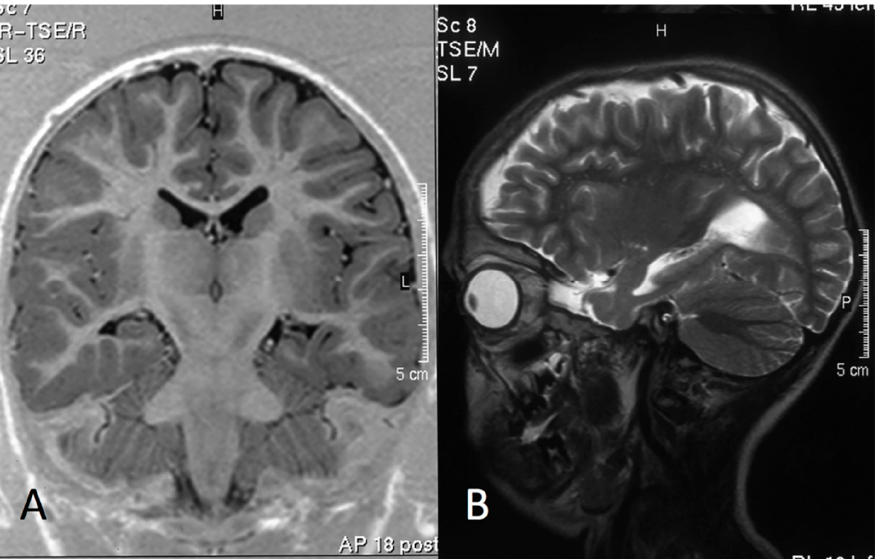
Figure 3. Group 1: MRI of a 11-year-old boy (Pt1, Lys 601Gln). ( A ) Inversion Recovery (IR) Turbo Spin Echo (TSE) Image, coronal plane. ( B ) TSE T2 weighted image, sagittal plane. The MRI shows a small left hippocampus and enlarged temporal horn and collateral sulcus, consistent with left-sided hippocampal sclerosis. Note the mild widening of left sylvian fissure and of the left fronto-temporal cerebrospinal fluid (CSF) spaces, consistent with cortical atrophy.